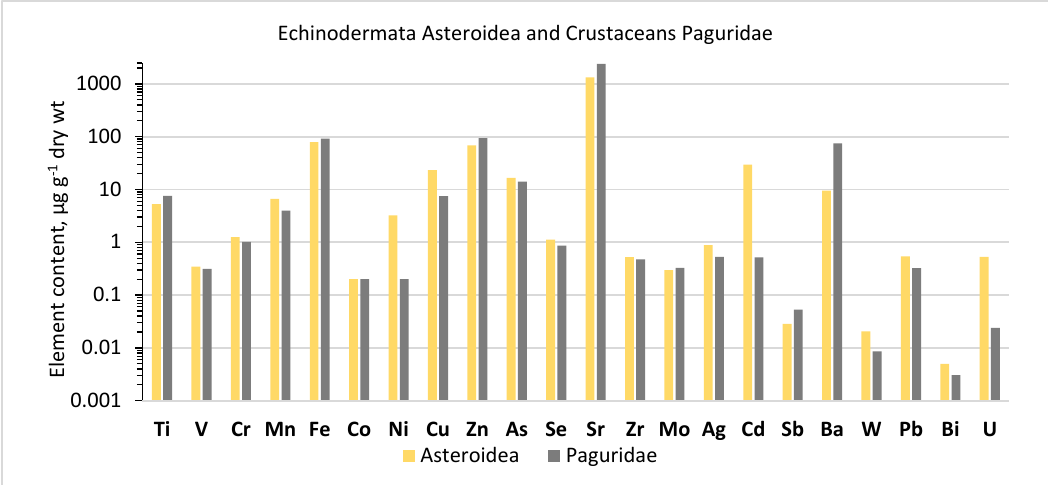
Figure 9. Distribution of elements in Asteroidea (Echinodermata) and Paguridae (Crustacea).